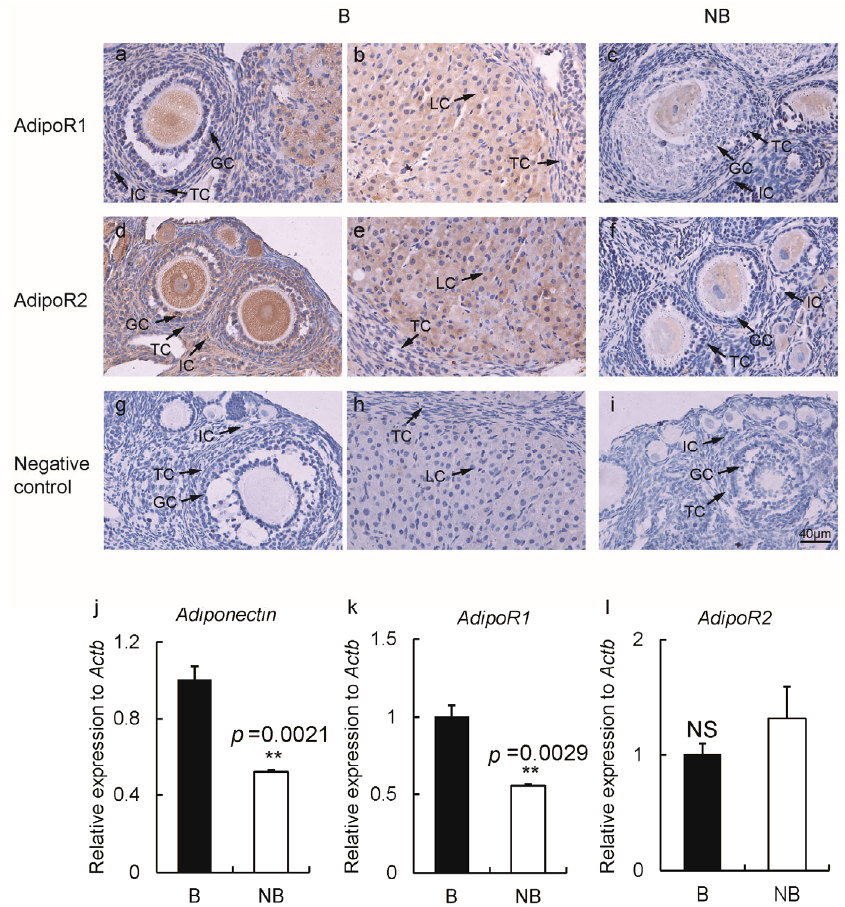
Figure 2. Immunolocalizations of AdipoR1 ( a – c ) and AdipoR2 ( d – f ) during the breeding season ( first two columns ) and the non-breeding season ( third column ). Negative control of two periods represented in the last row ( g – i ). The gene expression levels of Adiponectin ( j ), AdipoR1 ( k ), and AdipoR2 ( l ) in the breeding and non-breeding periods ( n = 3 for each group). Abbreviations: B represents the breeding season; NB represents the non-breeding season; GC represents granulosa cells; TC indicates theca cells; IC indicates interstitial cells; LC represents luteal cells. Bar, 40 µ m. The error bars represent means ± s.e.m. ** represented p < 0.01; NS represents no significance. Table 1. Relative abundance of target proteins of AdipoR1 and AdipoR2 in the ovaries of wild ground squirrels during the breeding and non ‐ breeding seasons.